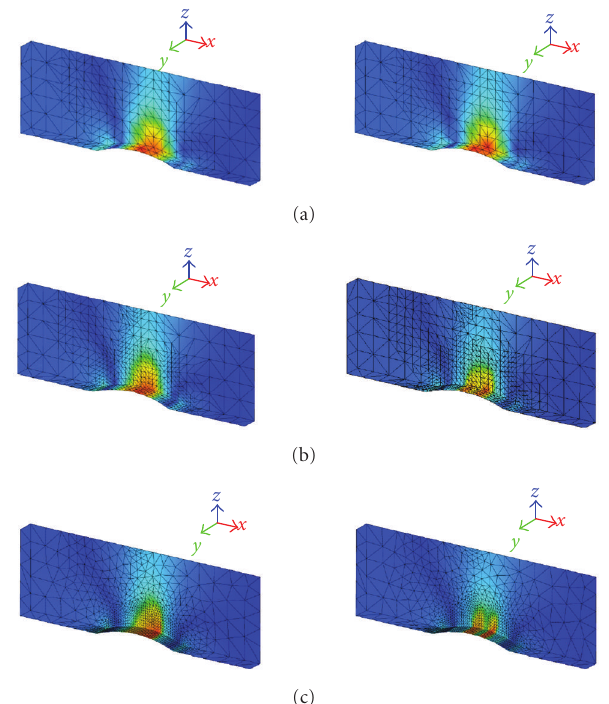
Figure 19: Adaptation/flow steps with (left) and without (right) projection—(a) first, (b) second, and (c) third. Solution field is C p .